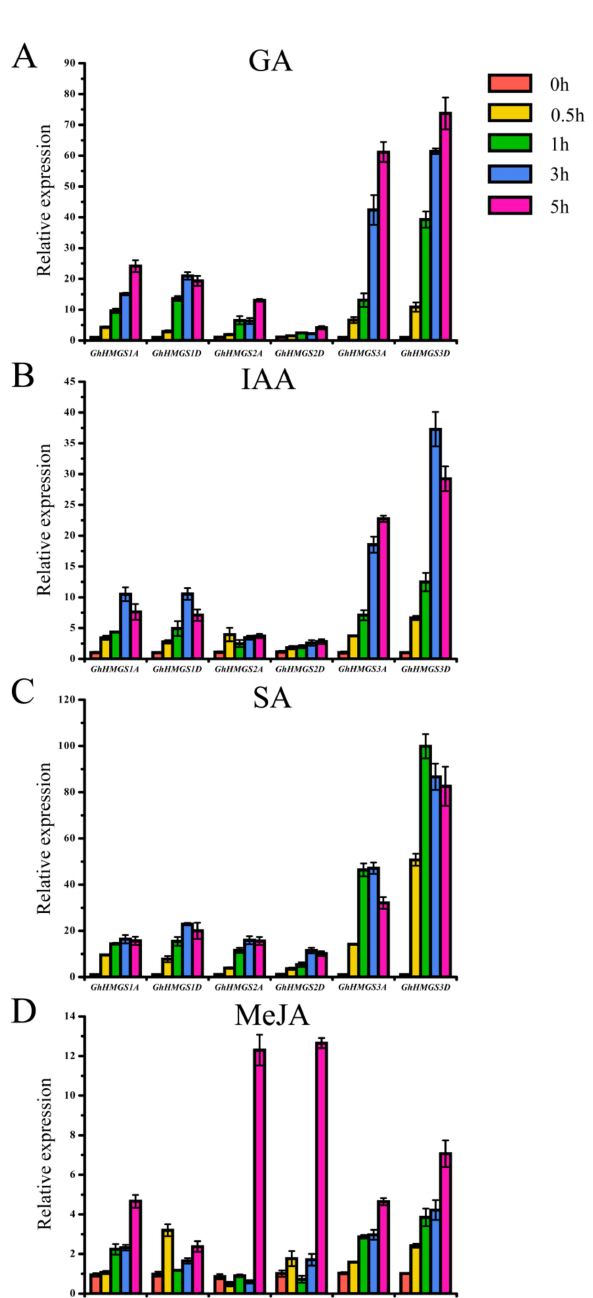
Figure 5. Expression analysis of G. hirsutum HMGS genes under phytohormone treatments. ( A ) GA; ( B ) IAA; ( C ) SA; ( D ) MeJA. The relative expression levels of GhHMGS genes under di ff erent phytohormone treatments were calculated with the cotton UBQ7 gene as an internal control. Error bars represent the standard deviations estimated from three independent